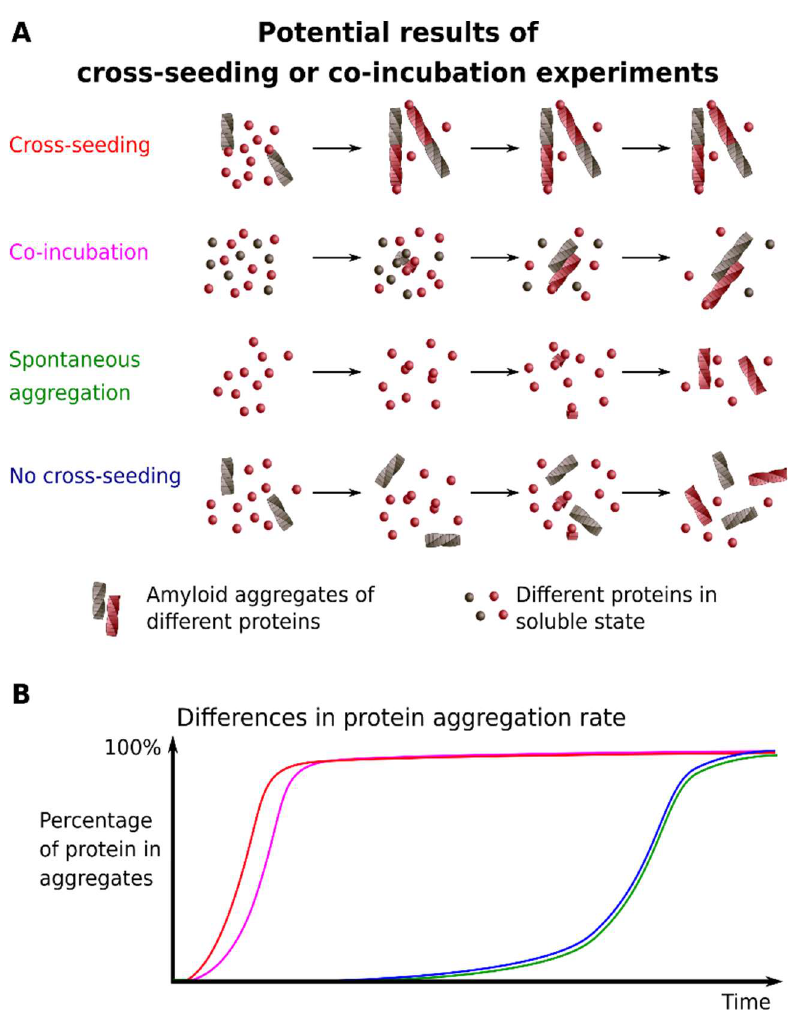
Figure 2. Schematic representation of cross-seeding and co-incubation. ( A ) The differences between molecular events upon cross-seeding or co-incubation of proteins. ( B ) The plot shows relative differences in the protein aggregation rate in cases shown on A. Colors on both panels correspond to each other.